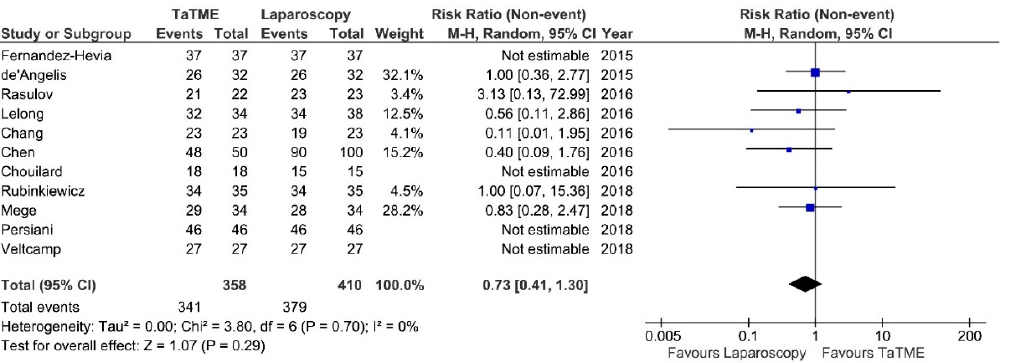
Figure 8. R0 resection rate. CI—Confidence Interval; df—degrees of freedom, M-H—Mantel-Haenszel test. WMD and RR are presented on the graphs as squares, and overall WMD and RR is presented as